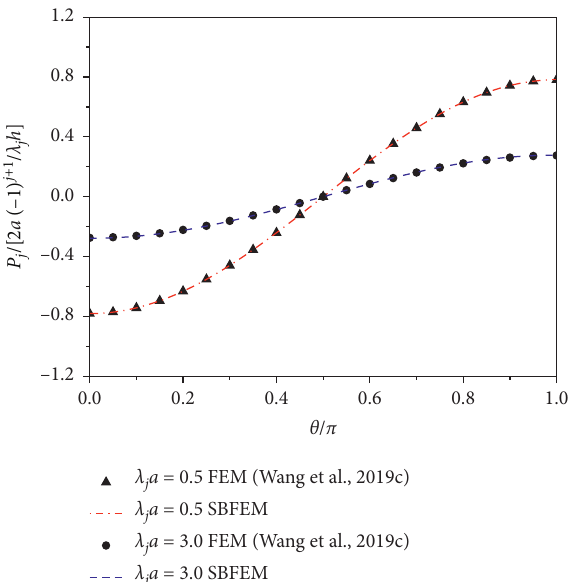
Figure 4: Hydrodynamic pressures P FEM [33] versus SBFEM.